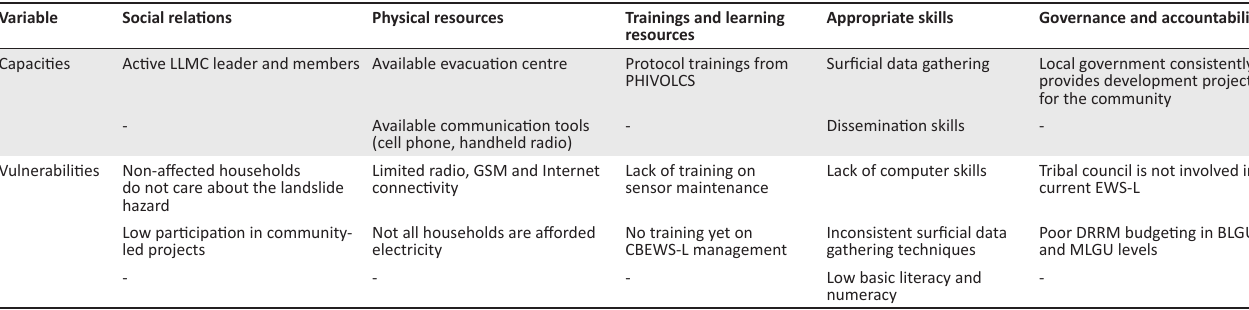
TABLE 3: Categorised capacities and vulnerabilities of site